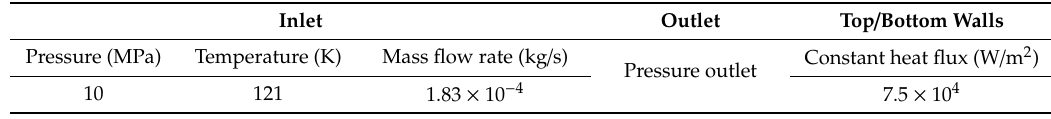
Figure 2. Geometric sizes of the zigzag channel, the zigzags with the inserted straight channels, and the zigzag channel with radian. Table 1. Details of boundary conditions.